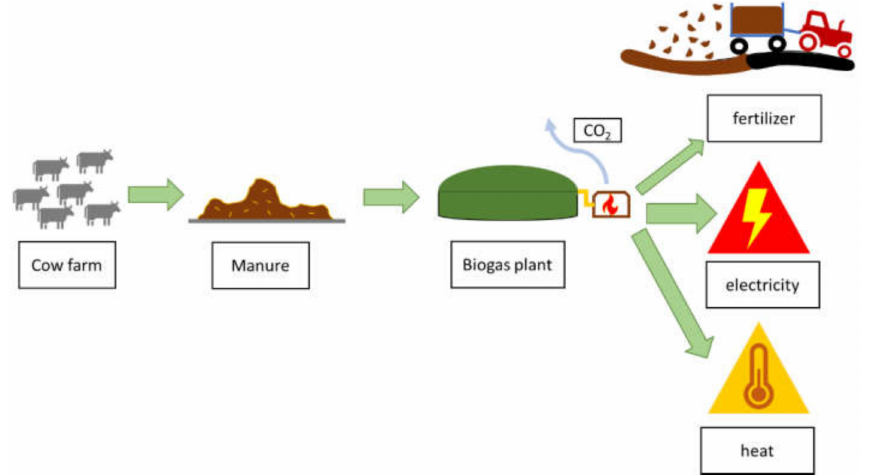
Figure 2. Scheme of Scenario II, manure storage